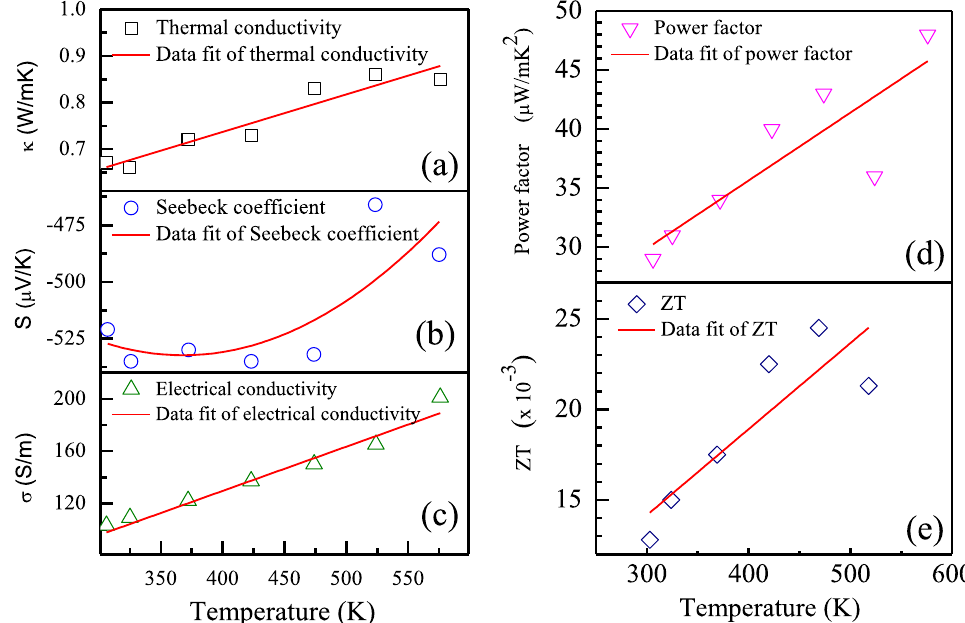
Figure 1. Thermoelectric properties of the CaMnO 3 sample: ( a ) thermal conductivity, ( b ) Seebeck coefficient, ( c ) electrical conductivity, ( d ) power factor (PF), and ( e ) figure of merit (ZT) as a function of